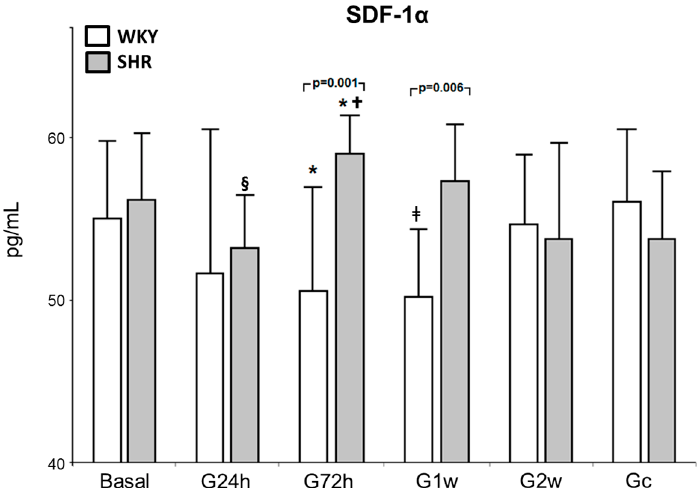
Figure 2. Systemic release of SDF-1 in normotensive and hypertensive rats after daily supplementation with ω -3. Normotensive (WKY) and hypertensive (SHR) animals had plasma collected in basal period and after 24 h, 72 h, 1 and 2 weeks of ω -3 supplementation and after 2 weeks of water intake. Data are expressed in picograms/milliliter (pg/mL). The p values for comparisons between models at a specific time are shown in the panel. * p < 0.05 vs. Gc; § p < 0.05 vs. G2w; † p < 0.05 vs. G24h; ‡ p < 0.05 vs. Basal. SDF-1, Stromal-Derived Factor-1; Gc, Control group; G24h, 24 h group; G72h, 72 h group; G1w, 1 week group; G2w, 2 weeks group.